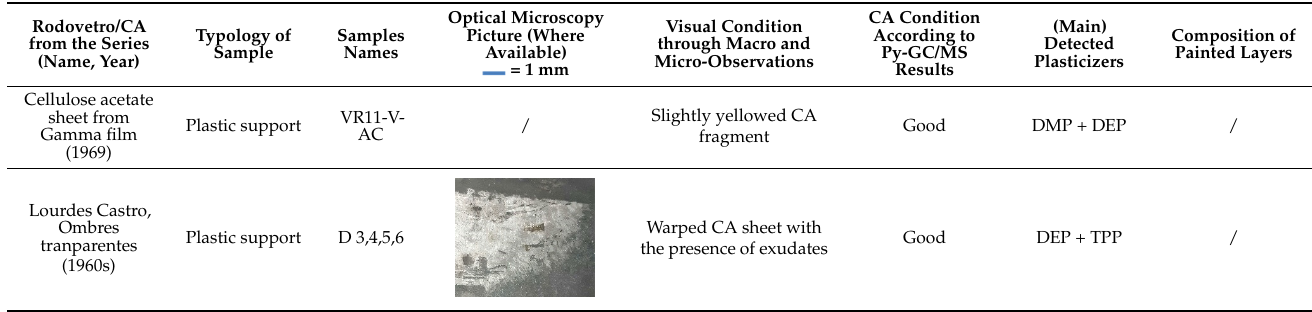
Figure 1. Visible light images of the analyzed Rodovetri: ( a ) La Rosa di Bagdad (1949), ( b ) Vegetallumina (1959), ( c ) Caio Gregorio (1960), ( d ) Brandy Gran Senior (1974), ( e , f ) Serie Stock (nd). The animation cels exhibit several degradation phenomena which compromise in many cases the stability of the plastic support and the readability of the characters. Table 1 lists the samples of the animation cels selected for research, taken from both the plastic supports (cellulose acetate sheets) and from painted layers. These Rodovetri were created between 1949 and 1972 and represented the main characters of short, animated advertising spots. Table 1. Cel, description, visual inspected condition, condition by Py-GC/MS results, plasticizers added, paint composition formulation. DMEP = bis(2-methoxyethyl) phthalate; TPP = triphenyl Table 1. Cont. phosphate; DMP = Dimethyl phthalate; DEP = Diethyl